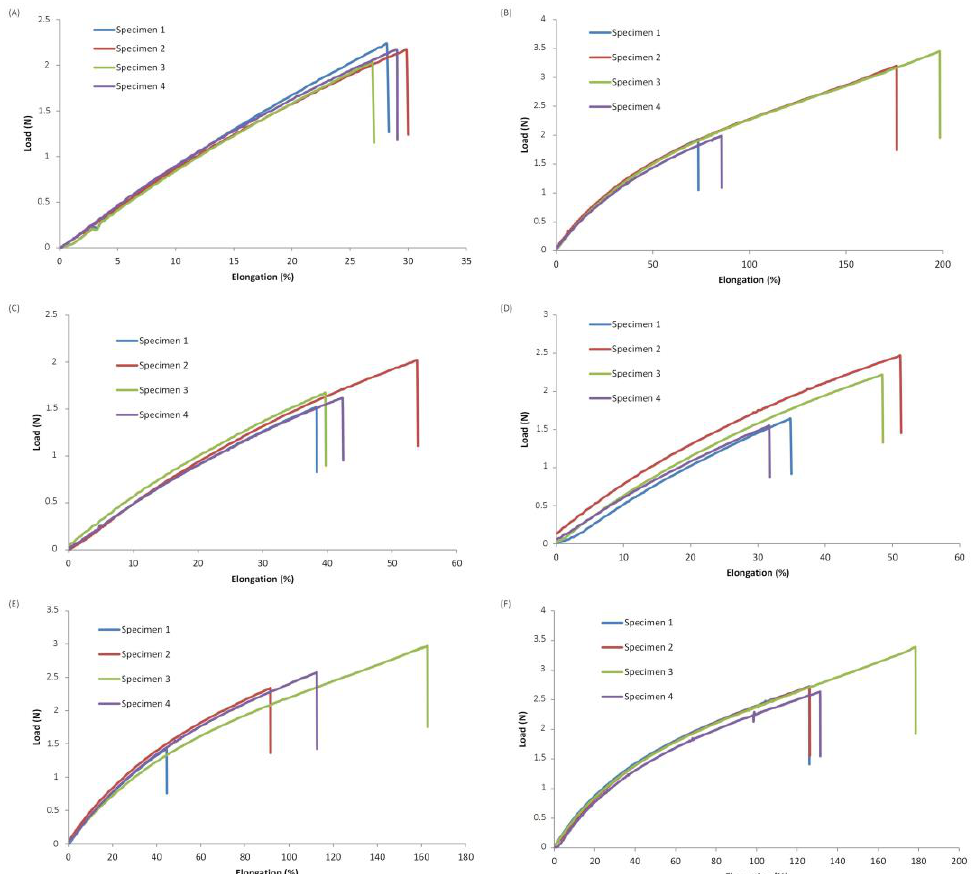
Figure 6. Tensile curves of Bio 2K PU-1 ( A ), Bio 2K PU-2 ( B ), Bio 2K PU-3 ( C ), Bio 2K PU-4 ( D ), Bio 2K PU-5 ( E ) and Bio 2K PU-6 ( F